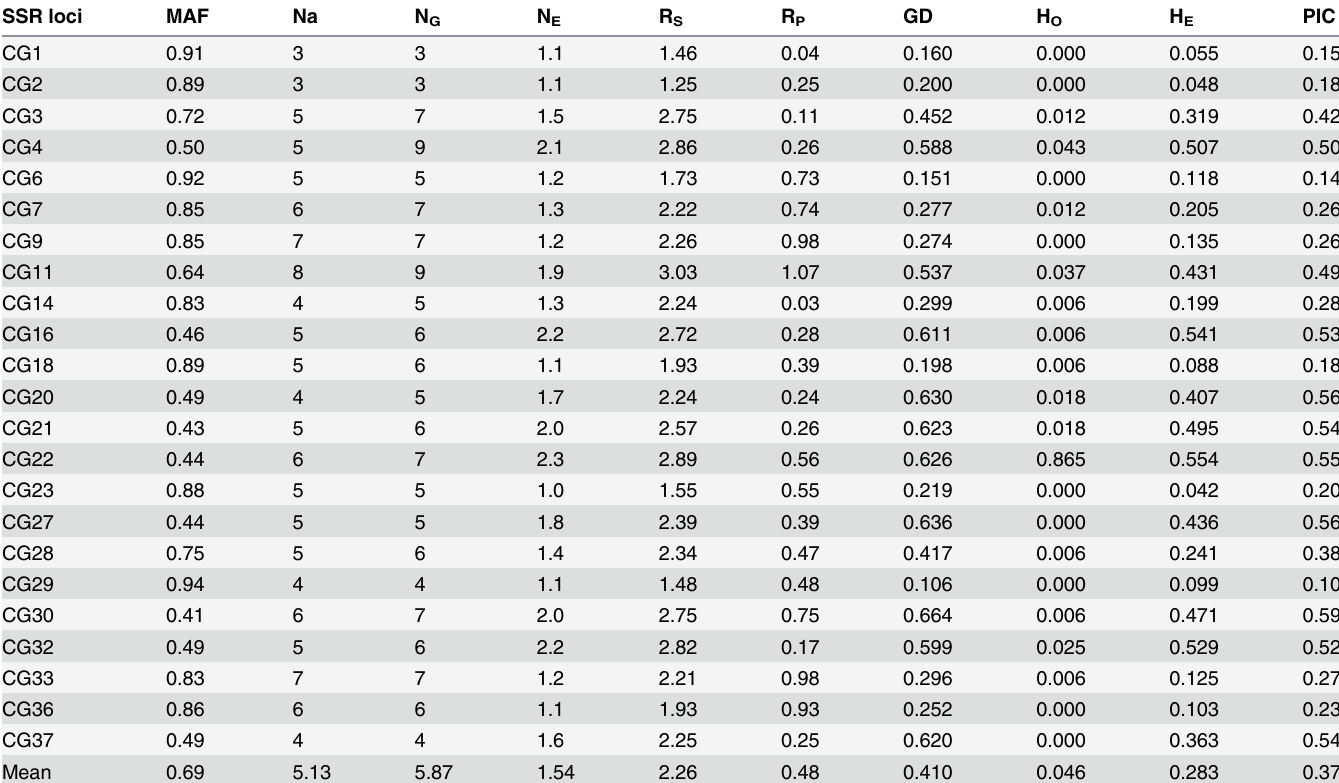
Table 3. Diversity indices of the microsatellite loci used in the